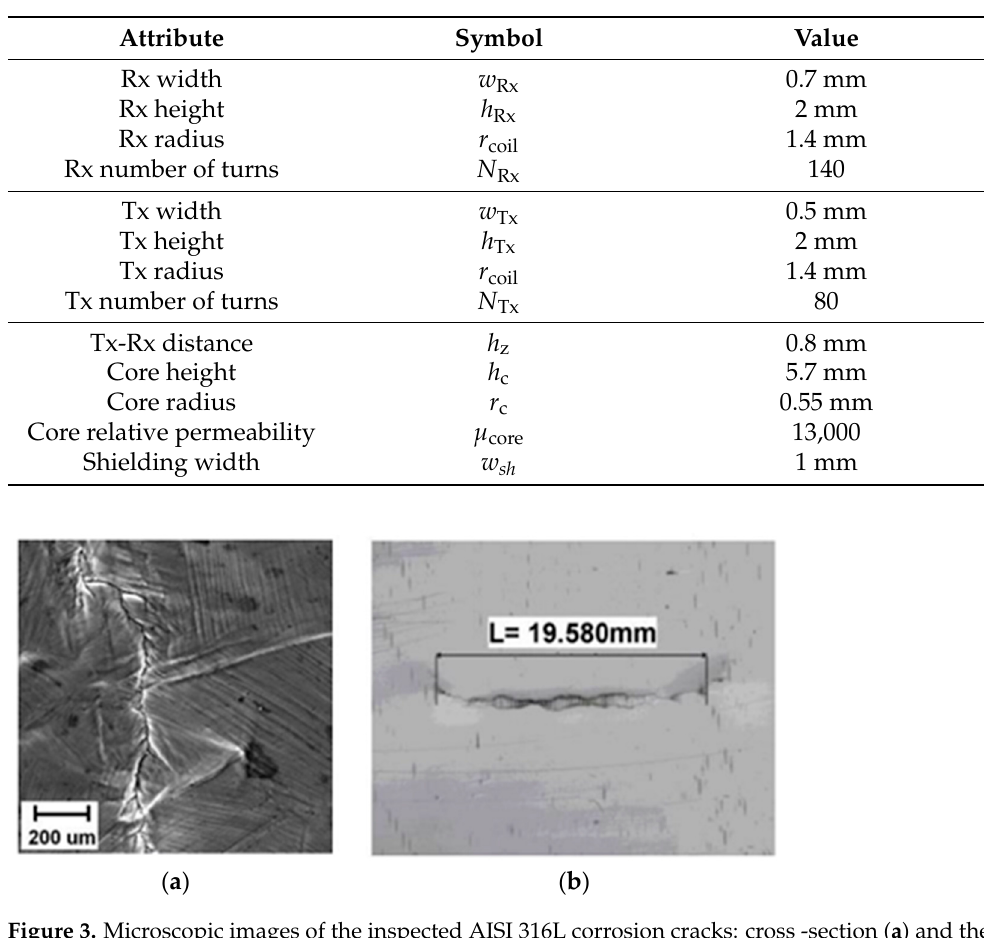
Table 1. The SFECT probes dimensions and properties.